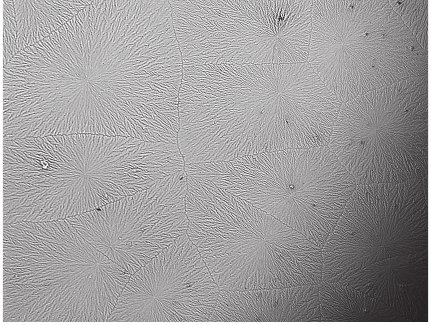
Figure 1: TF pattern obtained from a normal eye smoker.